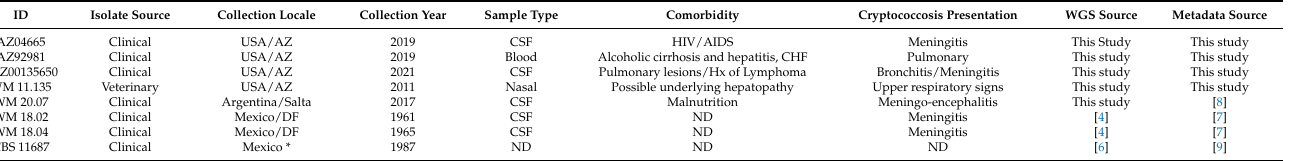
Table 1. Case information for C. gattii VGVI genomes. Definitions: CHF, congestive heart failure; CSF, cerebrospinal fluid; ND, not